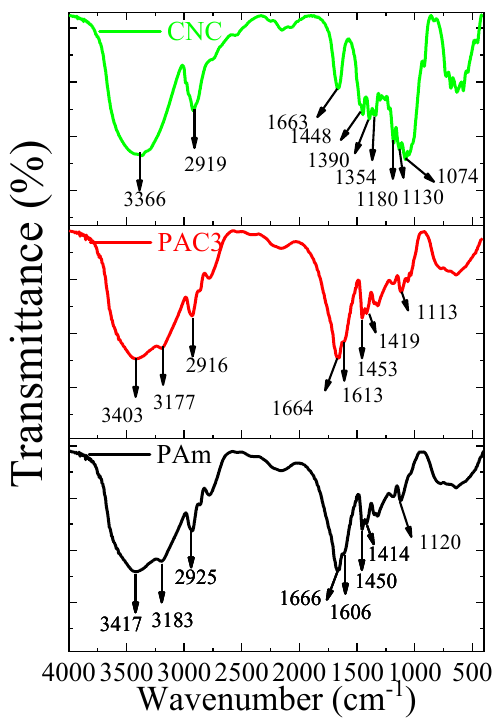
Figure 4. FTIR Spectra of PAm, CNC, and PAC3.